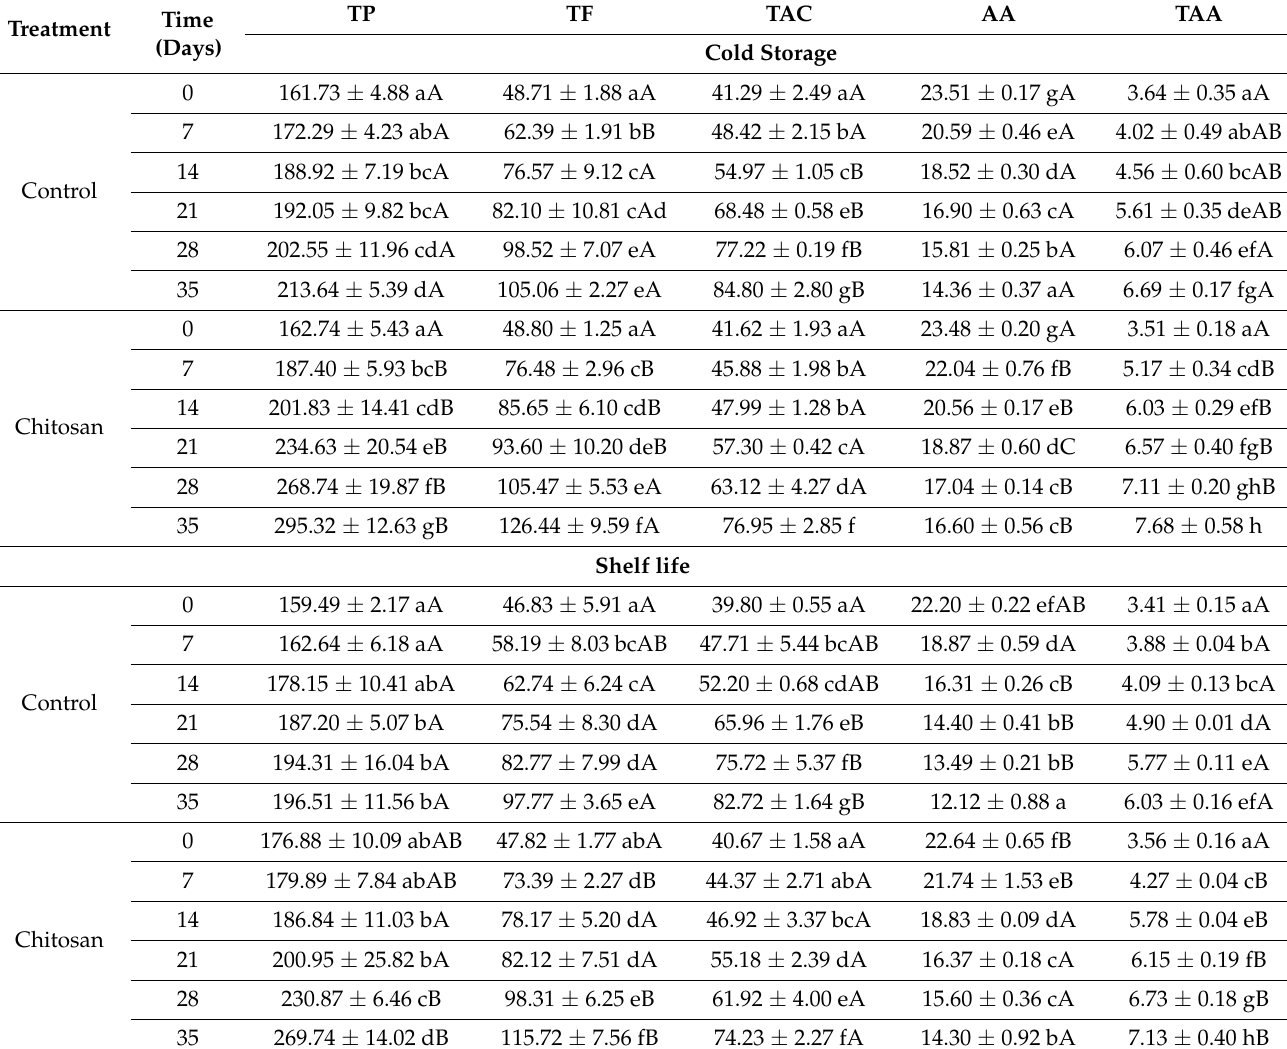
Table 2. Bioactive compounds content (TP: total phenols-mg GAE per 100 g FW; TF: total flavonoids- mg CE per 100 g FW; TAC: total anthocyanin-mg C3g per 100 g FW; AA: Ascorbic acid-mg AA per g FW) and antioxidant activity (DPPH- µ mol TE per g FW) at harvest (0) and after 7, 14, 21, 28